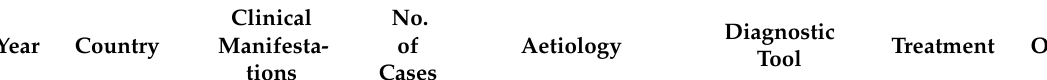
Table 11. Published cases of chromoblastomycosis in